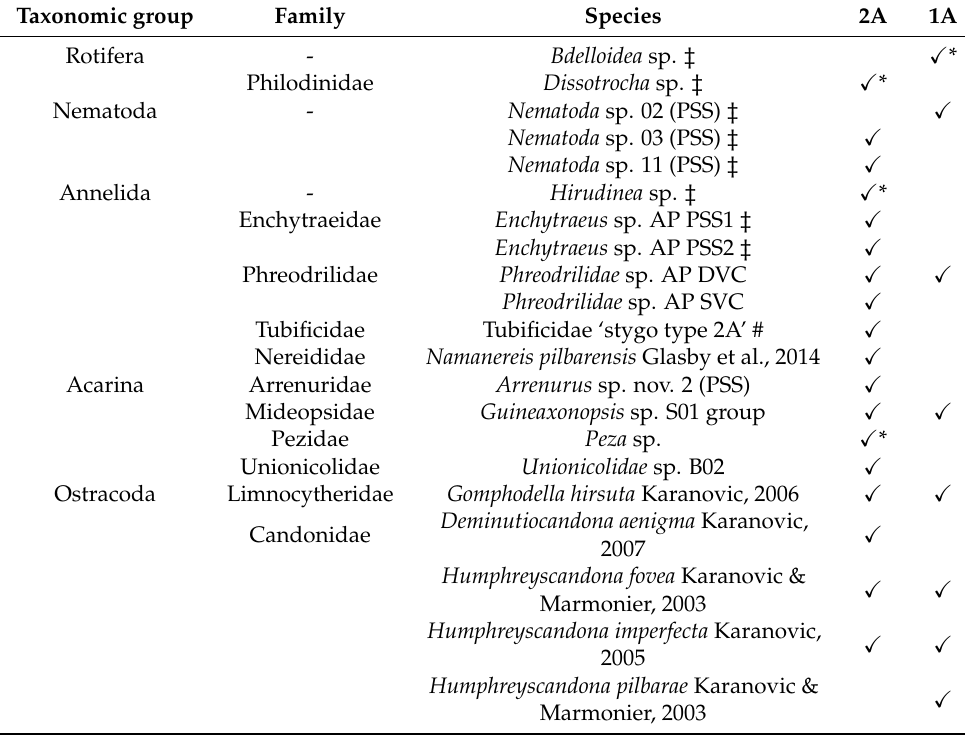
Table 2. Stygofauna species collected from wells Robe 2A and Robe 1A. Records with an asterisk represent identifications above species level. # indicates species are stygophiles, ‡ indicates uncertain status; all other species are likely